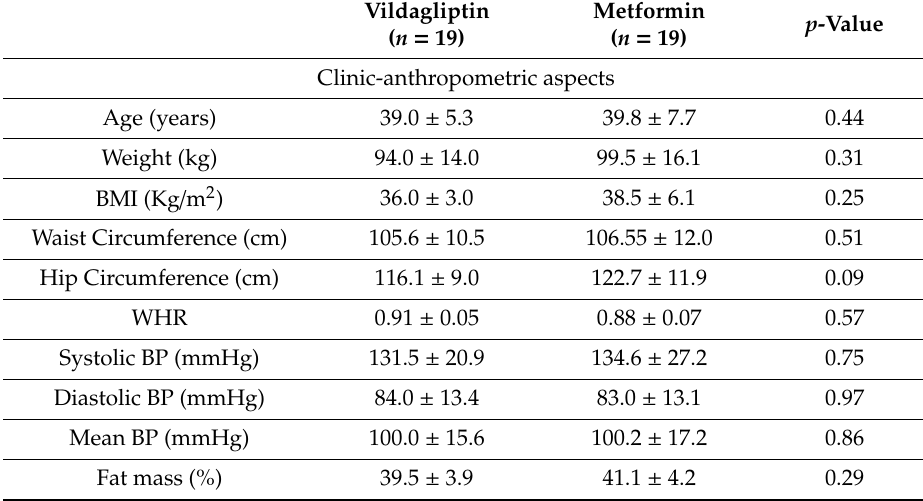
Table 1. Comparisons between vildagliptin and metformin groups on the clinic-anthropometric and laboratory variables at